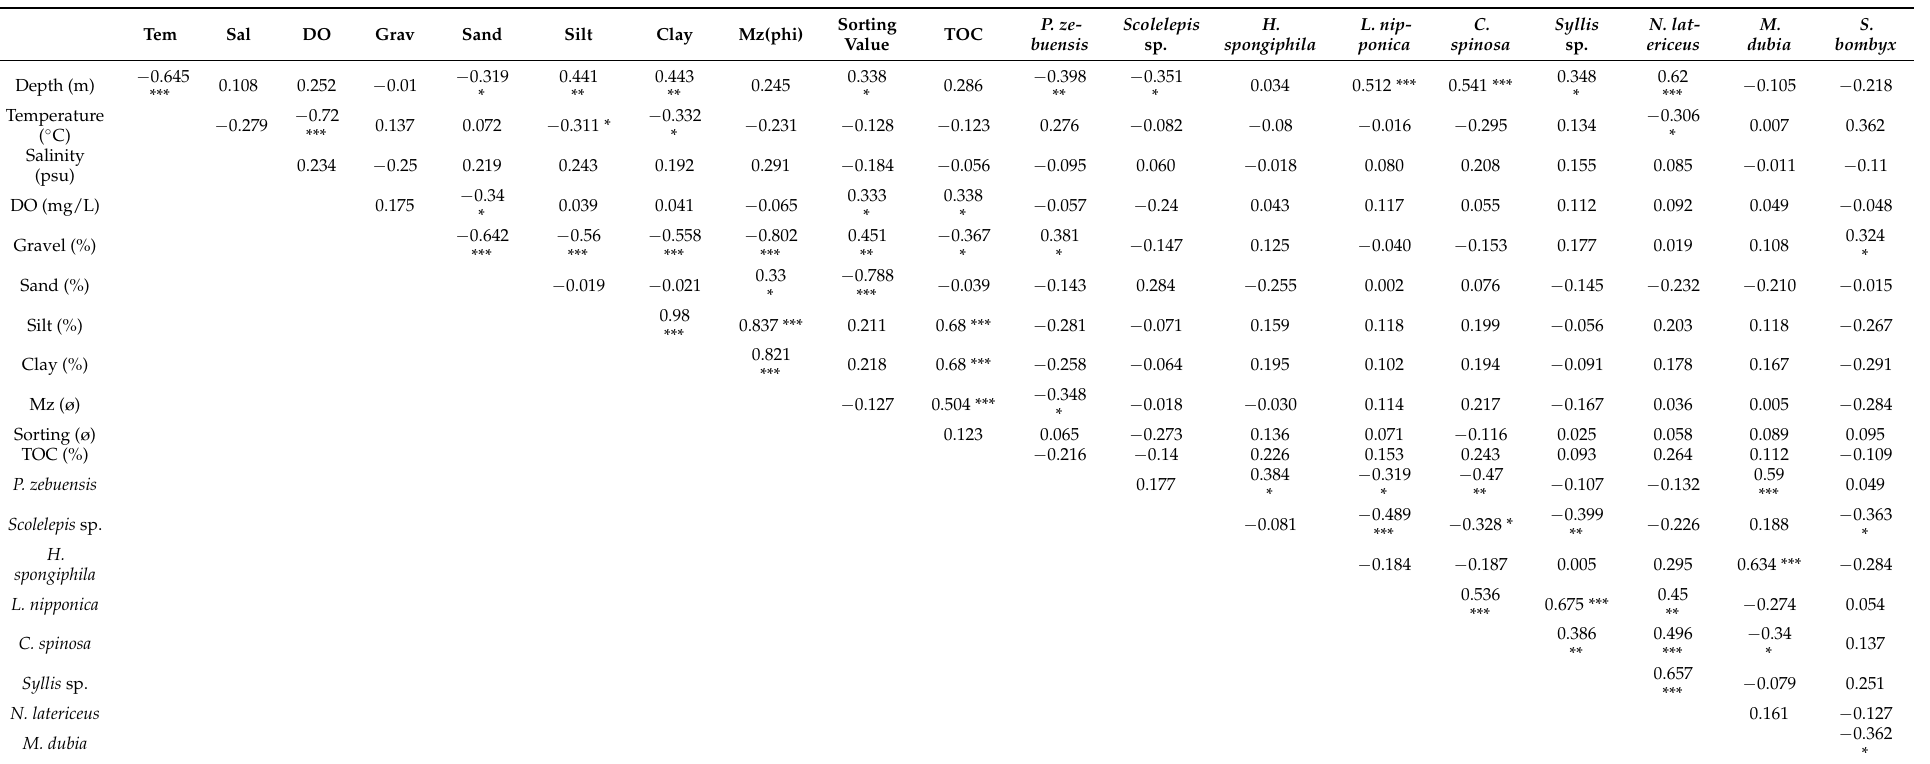
Table 7. Spearman rank correlation between the environmental and dominant species (* p < 0.05, ** p < 0.01, *** p <